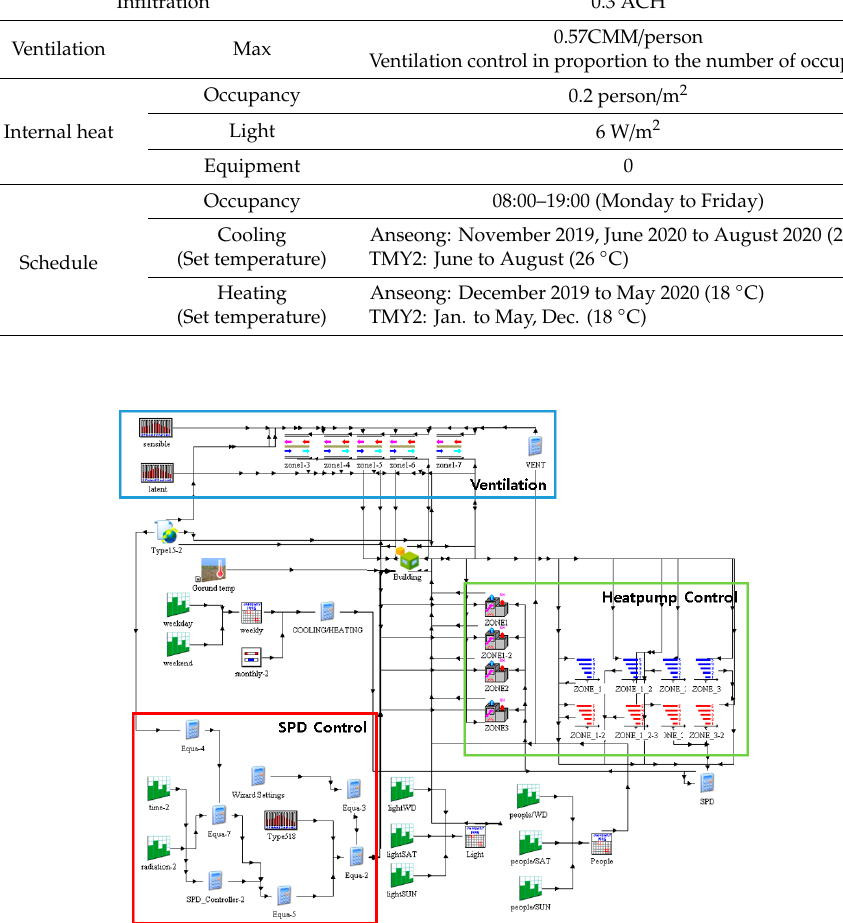
Figure 7. Configuration of standard building simulation Table 9. Effectiveness of energy recovery ventilation system.